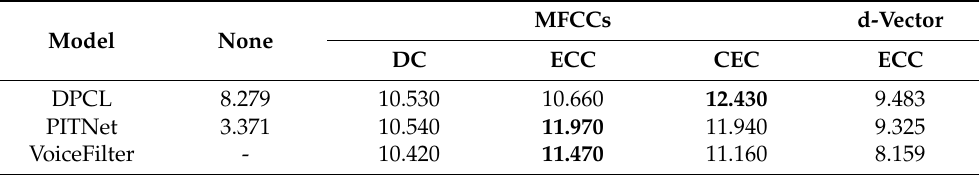
Table 3. Average SDR values corresponding to the three speech separation models with and without voiceprint feature integration (unit: